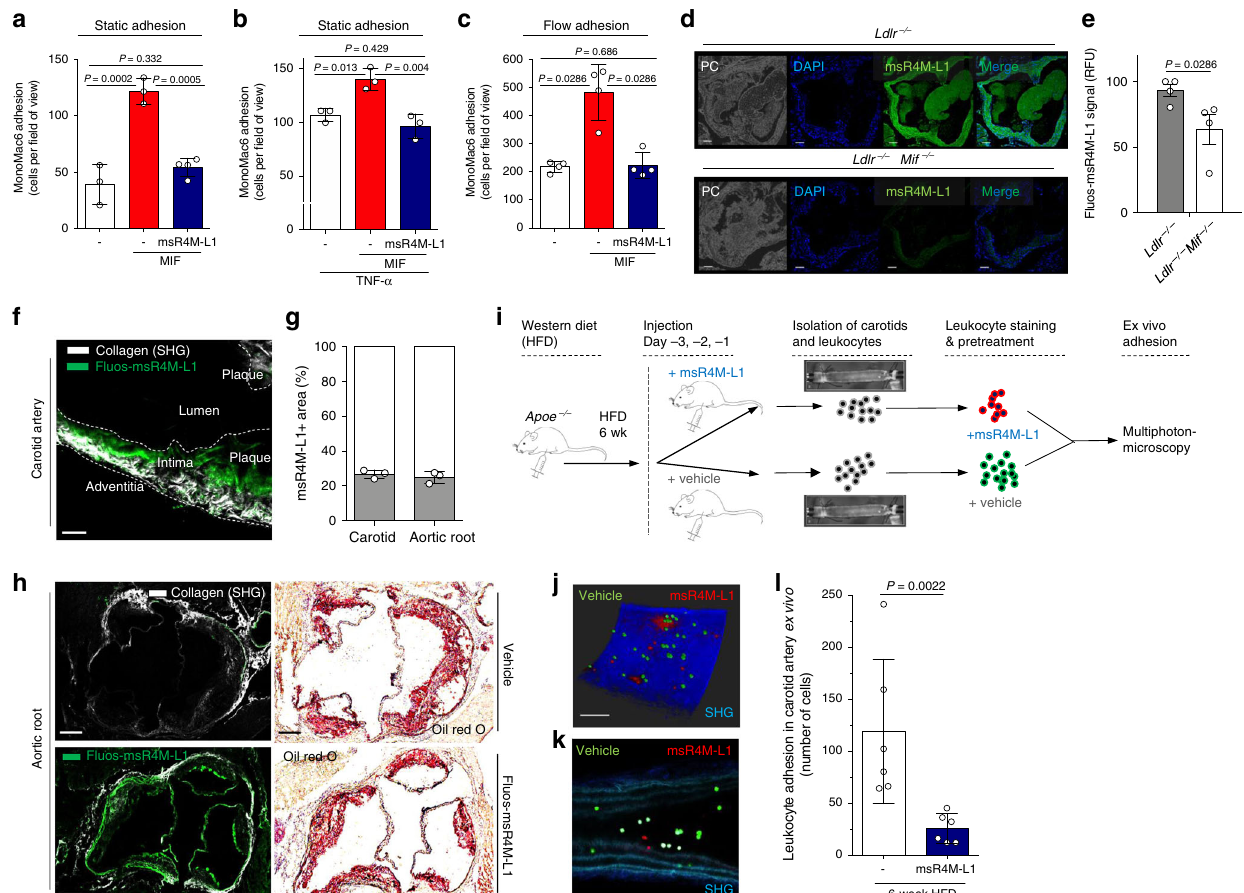
Fig. 5 msR4M-L1 localizes to atherosclerotic plaques in a MIF-speci fi c way and inhibits atherogenic leukocyte arrest. a , b MIF-induced static adhesion of MonoMac-6 monocytes to HAoECs is ablated by msR4M-L1. a Resting HAoECs. b As in a , except that HAoECs were pre-incubated with TNF- α . Quanti fi cation based on 3 experiments with 10 independent fi elds-of-view each. c MIF-induced adhesion of MonoMac-6 monocytes to HAoECs under fl ow conditions (1.5 dyn/cm 2 ) is ablated by msR4M-L1. One of two independent experiments with four analyses each. d , e Fluos-msR4M-L1 stains aortic root sections from atherogenic Ldlr − / − mice on HFD in a MIF-speci fi c manner (comparison between Ldlr − / − and Ldlr − / − Mif − / − mice). d Representative images (PC, phase contrast; DAPI, nuclei); e quanti fi cation (relative fl uorescence units) from two independent experiments with two animals each indicates MIF- speci fi c staining. f , g Multiphoton laser-scanning microscopy image ( f ) of a carotid artery prepared from a hyperlipidemic Apoe − / − mouse, showing that in vivo administered Fluos-msR4M-L1 localizes to atherosclerotic plaques. Vessel visualization by second harmonic generation (SHG). g Quanti fi cation of the Fluos-msR4M-L1-positive area (means of n = 3 sections) as percentage of vessel target-area. h (and g ) Same as f , g , except that aortic root was prepared (green in upper panel is auto fl uorescence). Quanti fi cation in g indicates ORO-positive target-area. i – l msR4M-L1 inhibits leukocyte adhesion in atherogenic carotid arteries under fl ow as analyzed by MPM. i Schematic summarizing the ex vivo leukocyte adhesion experiment. msR4M-L1 or vehicle was injected before vessel harvest; fl ushed leukocytes are stained in red (msR4M-L1; CMPTX) or green (vehicle; CMFDA). j Representative image of a carotid artery showing that pre-treatment with msR4M-L1 (red) leads to reduced luminal leukocyte adhesion compared to control (green), imaged by 3D reconstruction after Z-stacking (0.8 – 1.5 µ m) (blue: SHG). k Still image of a z sectioning video scan (single fi eld of view) through the artery (morphology revealed by SHG: collagen, dark blue; elastin, light blue). l Quanti fi cation of 5 – 6 independent carotid arteries per group. Luminally-adhering cell numbers are plotted. Scale bars: d , 50 µ m; f , 100 µ m; h , 100 µ m; j – k , 100 µ m. Data in a , b , c , e , g and l are reported as means ± SD. Statistical analysis was performed with one-way ANOVA with Tukey ’ s multiple comparisons test or two-tailed Mann – Whitney test as appropriate. The vessel icon in Fig. 5i was used with permission from S. Karger AG (Copyright © 2006, © 2007 S. Karger AG, Basel 78 ). msR4M-L1, MIF-speci fi c CXCR4 mimic-L1; MIF, macrophage migration- inhibitory factor. Source data are provided as a Source Data fi